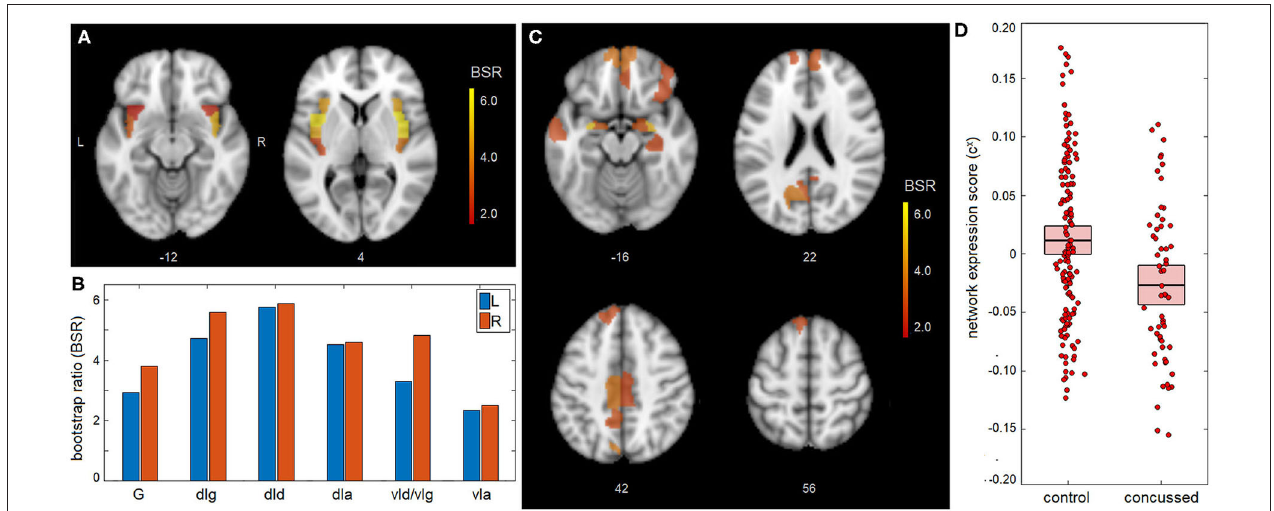
FIGURE 1 | Mean effect of concussion on insular network connectivity. (A,B) For the insular subnetwork, salience bootstrap ratios (BSRs) are displayed as a spatial map and as barplot values, ordered posterior-to-anterior. (C) For the full-brain subnetwork, salience BSRs are also shown as a spatial map. (D) Network expression scores, reflecting insular connectivity to the identified whole-brain network, are plotted for individual control and concussed athletes. The group means are plotted (horizontal black lines), along with the 95%CIs of the mean (boxes). Insular subregions include: hypergranular (G), dorsal granular (dIg), dorsal dysgranular (dId), dorsal agranular (dIa) ventral dysgranular/granular (vId/vIg), and ventral agranular